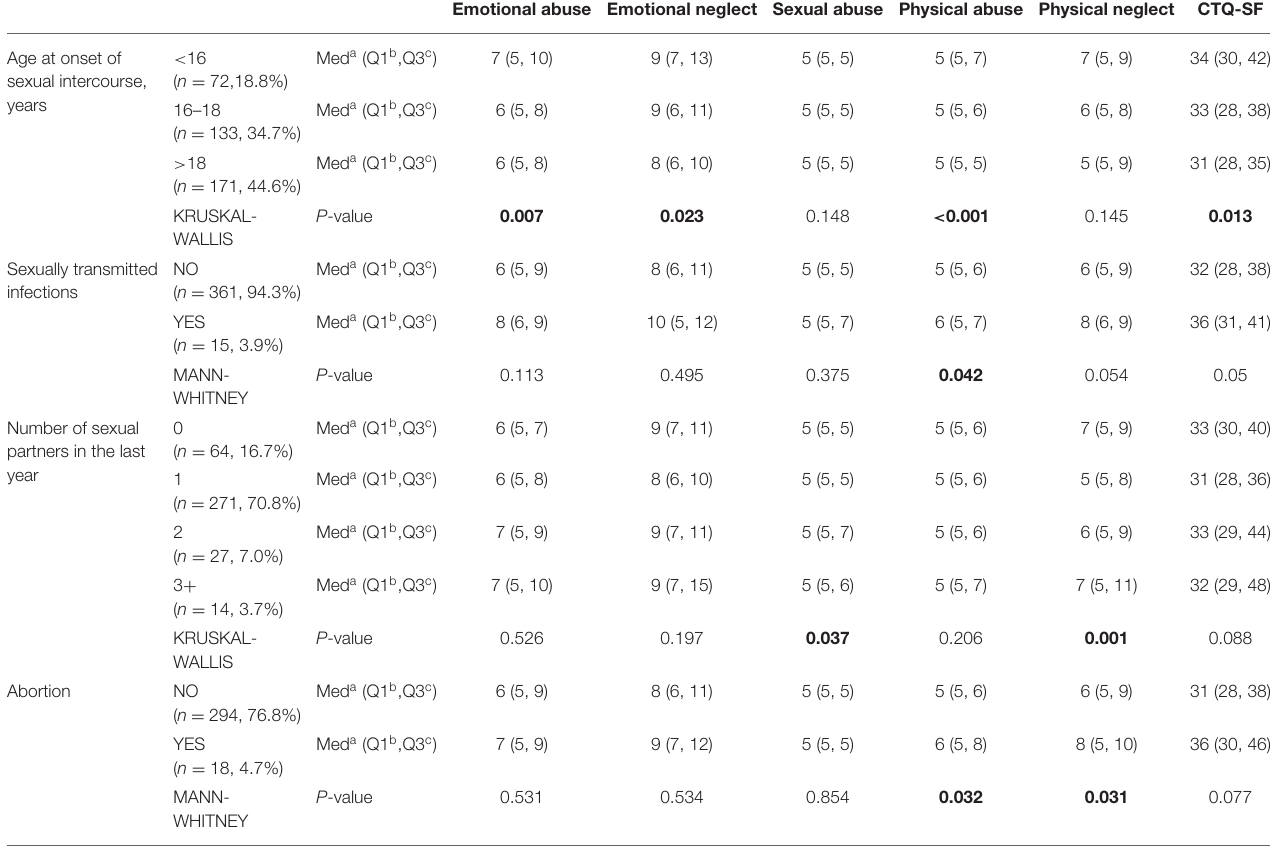
Emotional abuse Emotional neglect Sexual abuse Physical abuse Physical neglect CTQ-SF